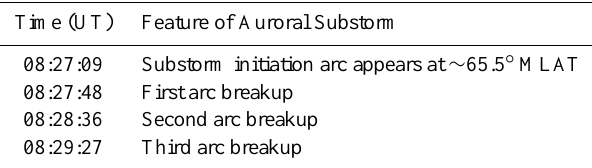
Fig. 2b. Evolution during 08:28:15–08:29:27UT of the 21 Decem- ber 2006 auroral substorm event observed by the THEMIS ASIs located at KIAN, GAKO, and WHIT. Table 2. Timings of auroral substorm arc onset and subsequent arc breakups for the 21 December 2006 substorm